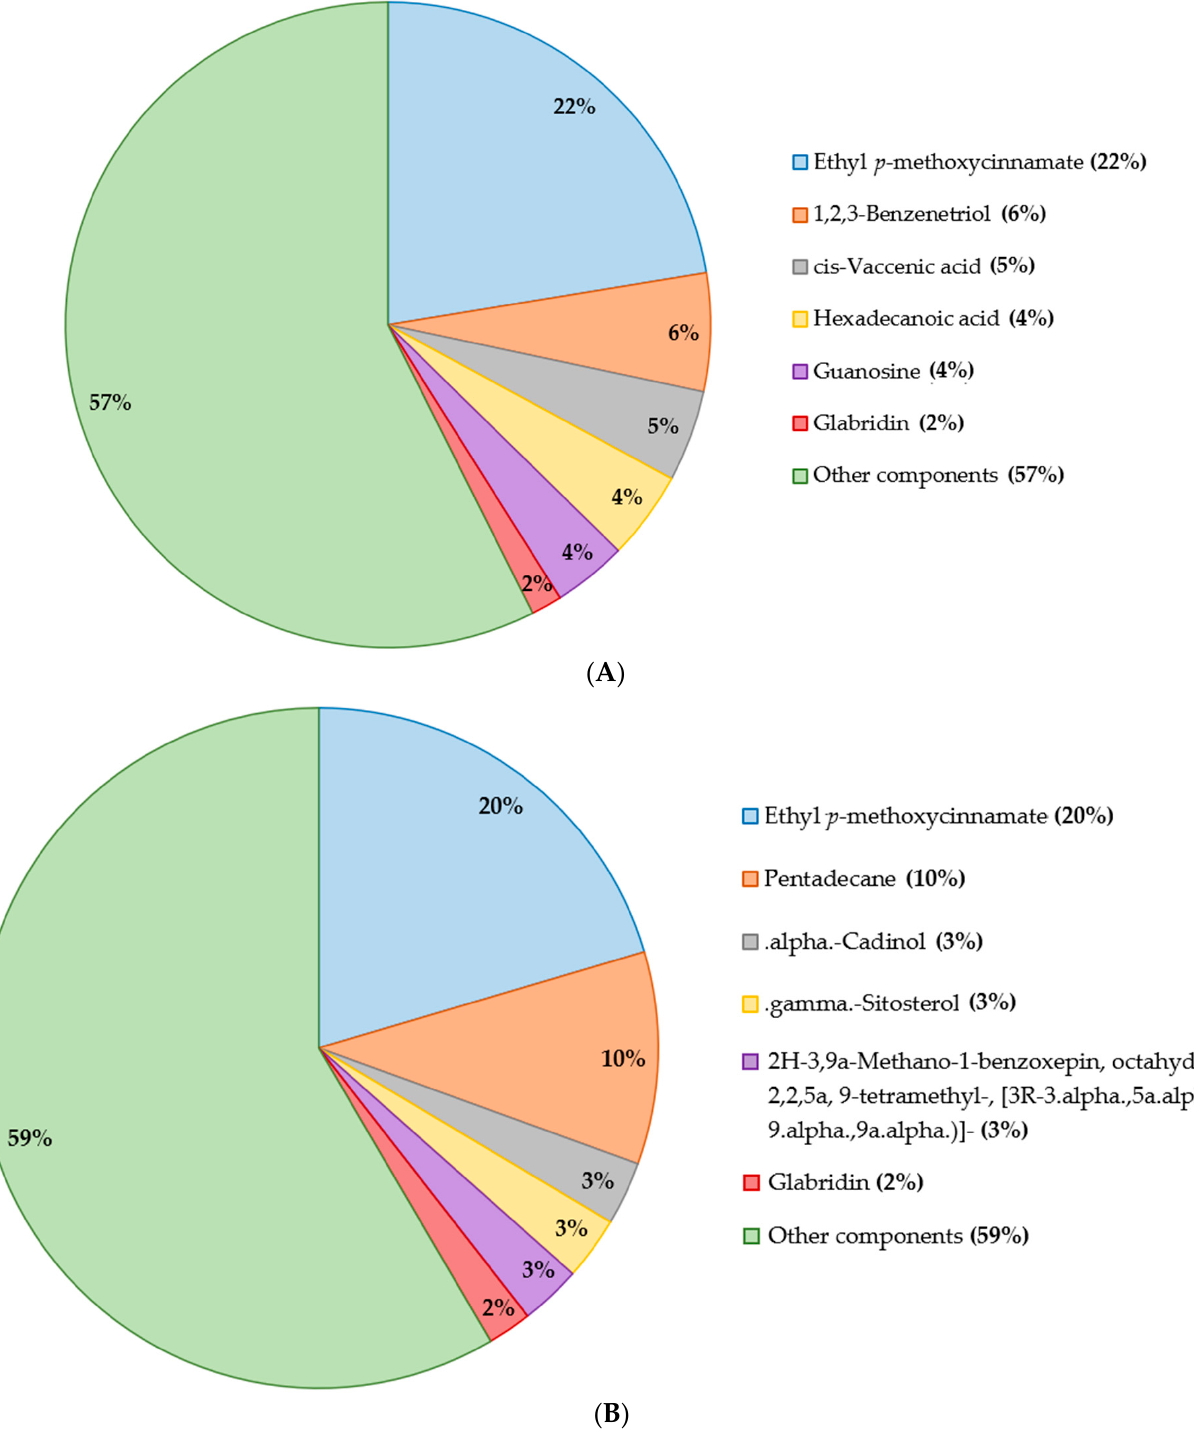
Figure 1. Total chemical component analysis of remedy extracts, presented in a pile chart (100%) using GC–MS. ( A ) Metabolites present in 80% ethanol extract. ( B ) Metabolites present in ethyl acetate extract.